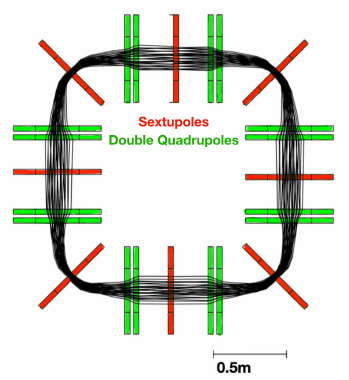
Figure 1. Sketch of the storage ring with bending elements, focussing elements, SQUIDs, spin tuning coils and RF buncher.